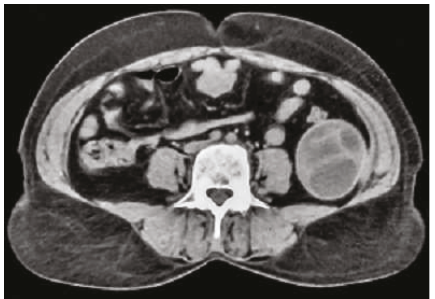
Figure 1: CT scan of abdomen showing giant lobulated hydatid cyst in the right lobe of the liver.